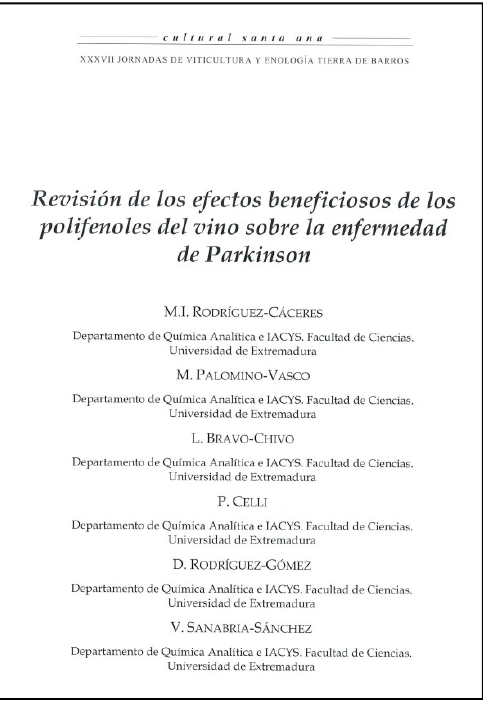
Figure 3. First page of the review presented in